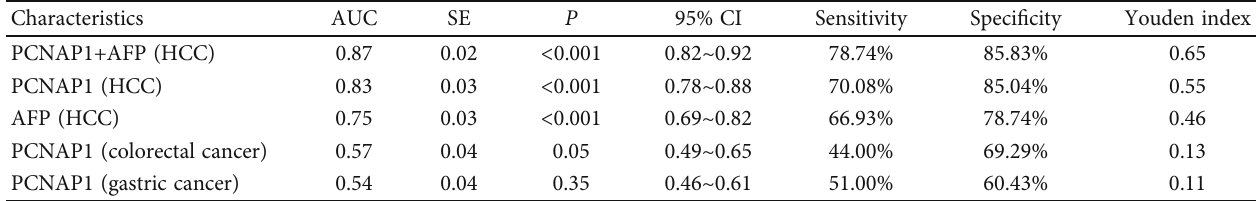
Table 2: ROC curve analysis of the use of plasma PCNAP1 for diagnosis and di ff erential diagnosis of hepatocellular carcinoma.